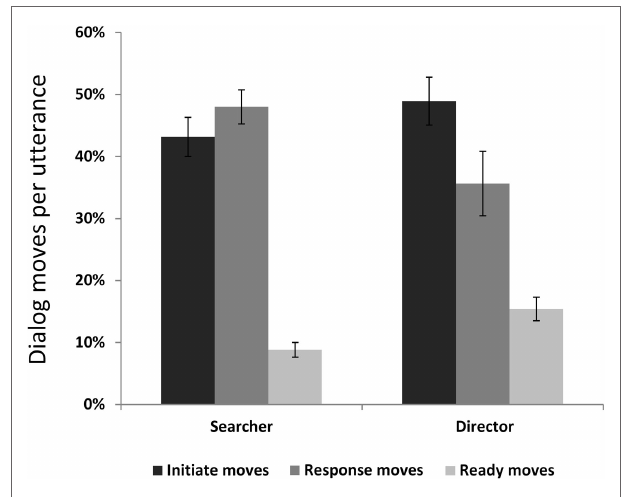
FigUre 3 | Distribution of dialog moves by speaker role under time pressure . Error bars represent SEM.